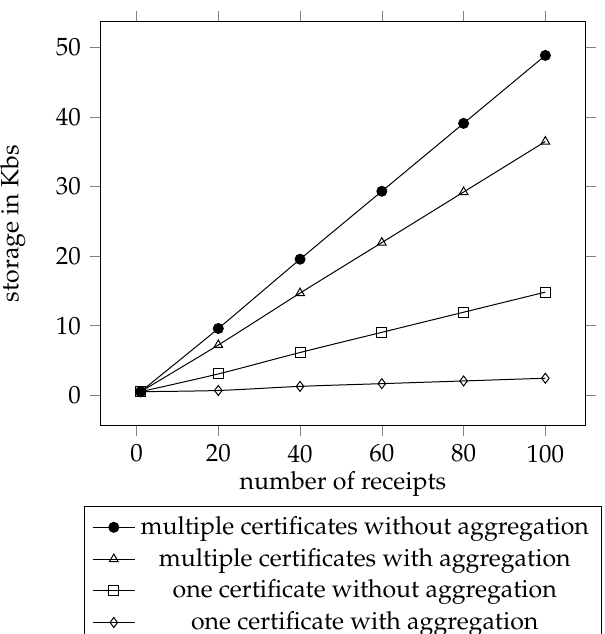
Figure 5. Receipt storage